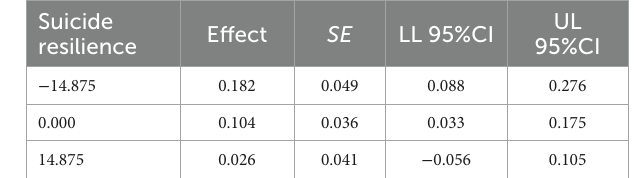
TABLE 6 Conditional indirect effects of symptom distress on suicidal ideation at values of